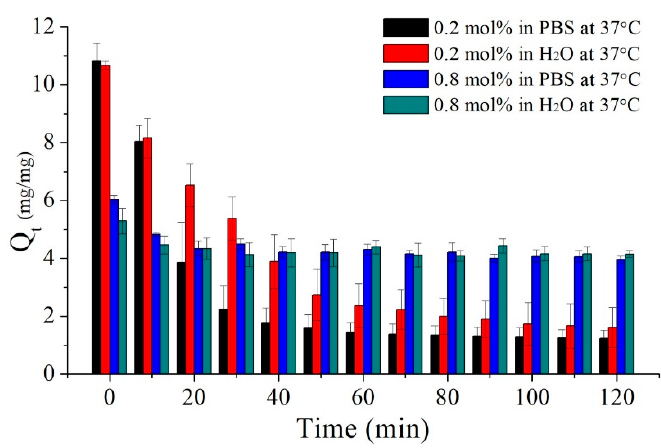
Figure 9. The bar chart presents the deswelling ratios of poly(MEO 2 MA) hydrogel, crosslinked with 0.2 mol % and 0.8 mol % of DEGDMA at 37 °C in PBS solution and Milli-Q water, respectively.